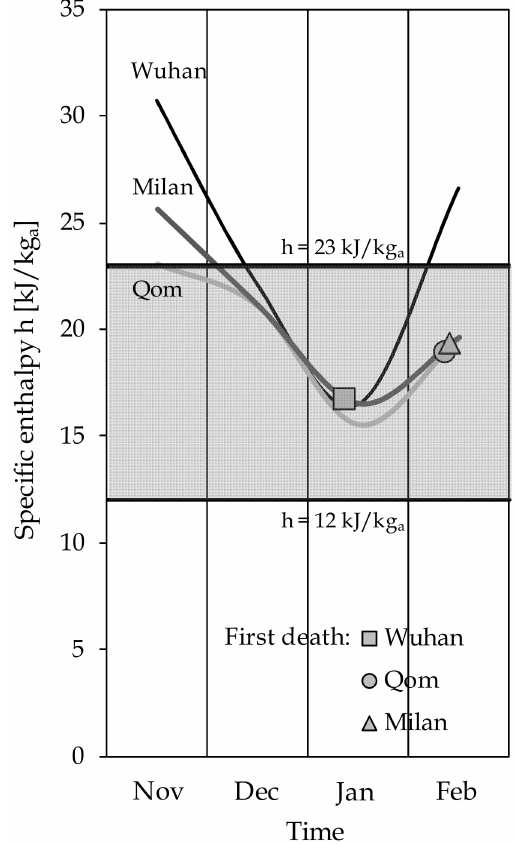
Figure 6. Time evolution of the monthly average specific enthalpy (h) statistical values from November 2019 to the time of the first COVID-19 related death in the most adversely a ff ected